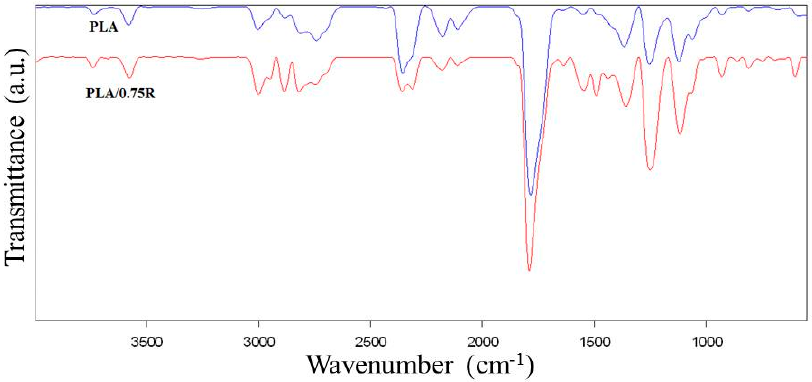
Figure 11. 2D FTIR spectra of the thermal degradation products resulting from PLA and PLA/0.75R.